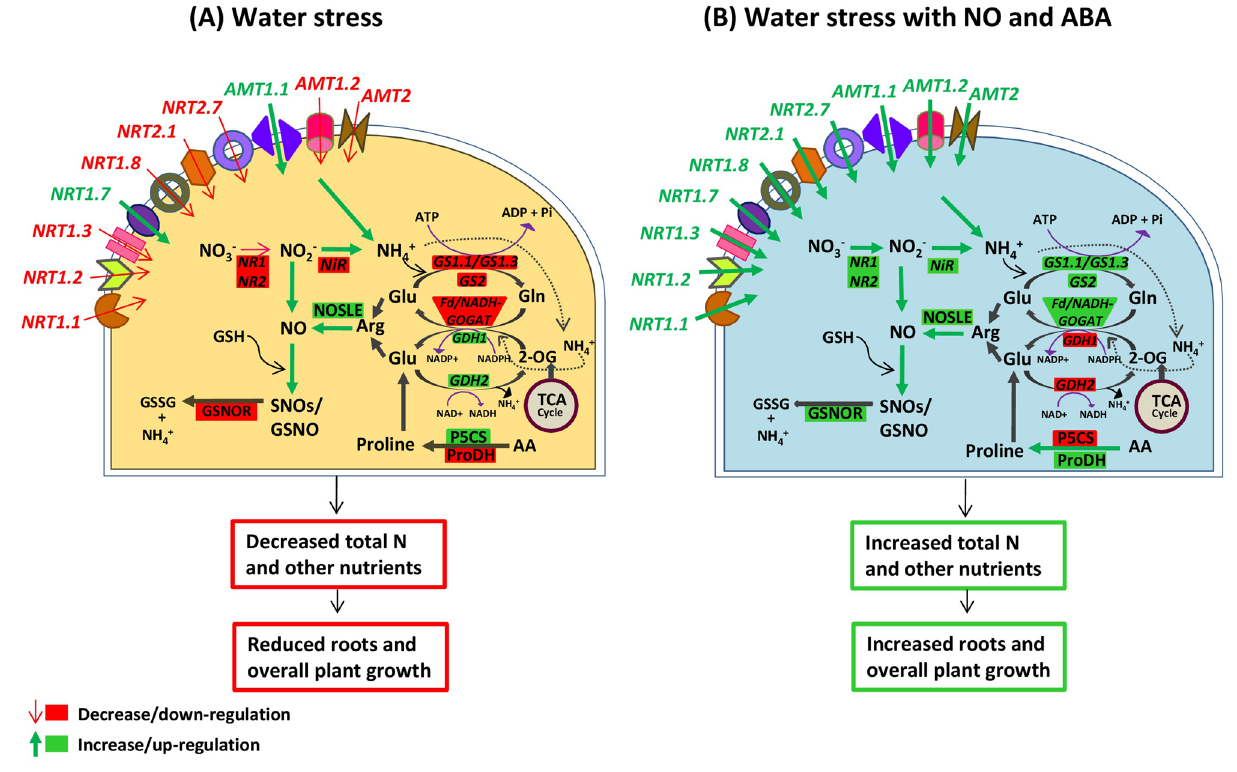
Figure 7. A schematic comparison of ( A ) PEG-water stress and ( B ) nitrate agonists regulated N–NO coordinated underlying physiological phenomenon that shows the relationship of NO generation and scavenging to molecular mechanism of N-assimilation in B. juncea L. roots. Red boxes and narrow arrows represent decrease or down-regulation, while green boxed and wide arrows indicate increase or up-regulation in N–NO pathway. NO 3 − nitrate, NO 2 − nitrite, NH 4 + ammonium, SNO S-nitrosylated glutathione, GSNO S-nitrosoglutathione, NO nitric oxide, Glu glutathione, AA amino acids, GSSG oxidised glutathione, P5CS ∆ 1 -pyrroline-5-carboxylate synthetase, ProDH proline dehydrogenase, NR nitrate reductase, NiR nitrite reductase, NOSLE l-arginine dependent NOS-like enzyme activity, GSNOR S-nitrosoglutathione reductase, GS glutamine synthetase, GOGAT glutamate synthase, GDH glutamate